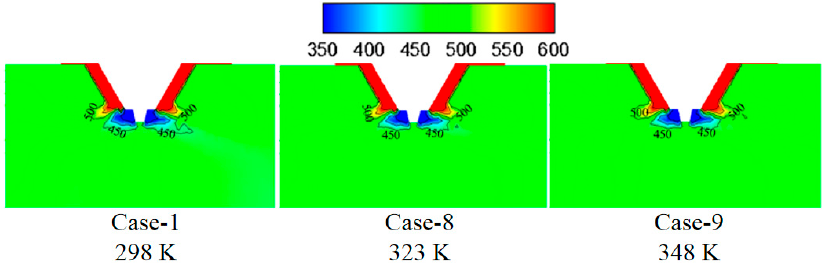
Figure 14. Temperature under different wastewater initial temperatures (K).